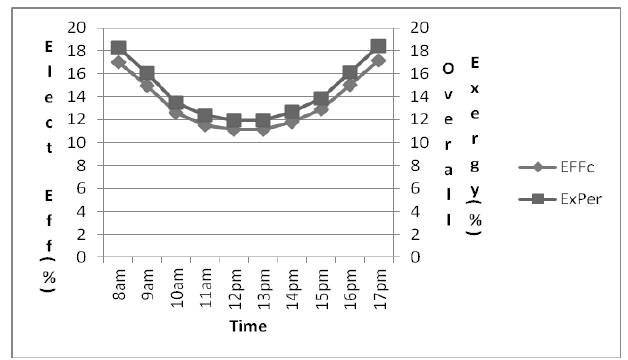
Figure 8. Variation of Electrical and Exergy Efficiency w.r.t